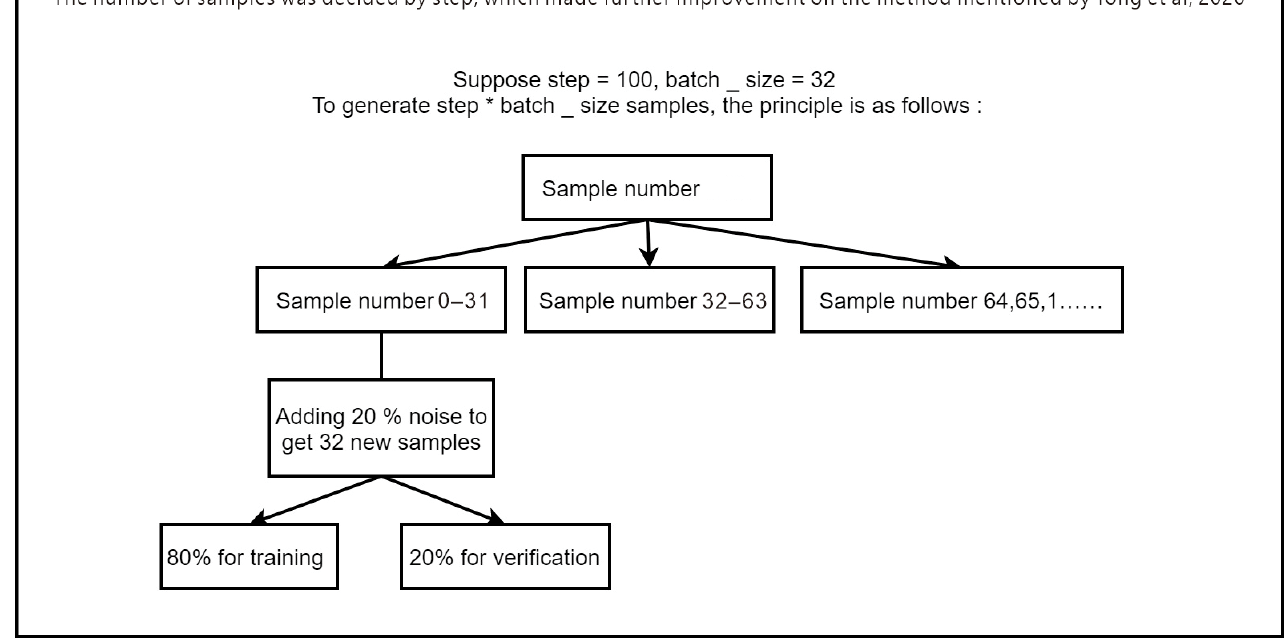
Figure 9. The principle of sample expansion.